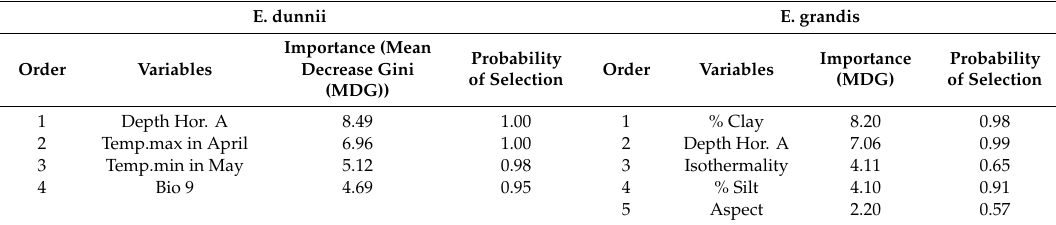
Table 2. Ranking of the importance of independent variables for prediction of the distribution of Eucalyptus dunnii and E. grandis .